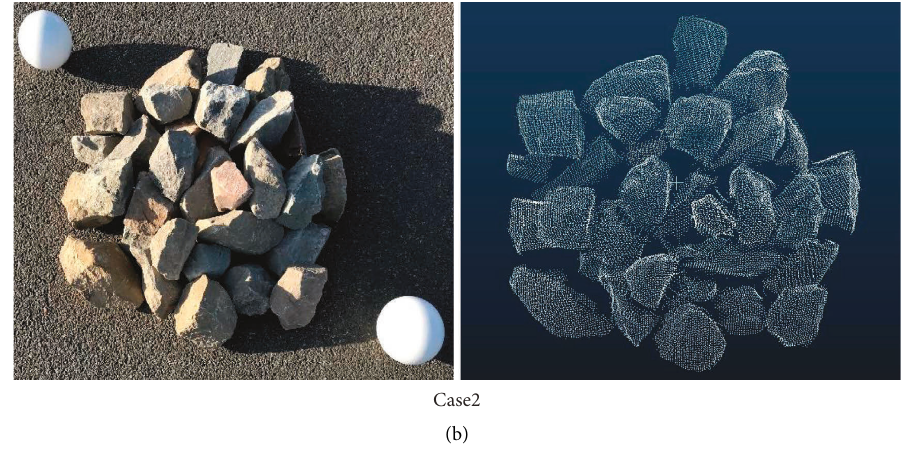
Figure 9: stacked blocks with different layouts in the lab experiments. (a) Case 1. (b) Case 2.